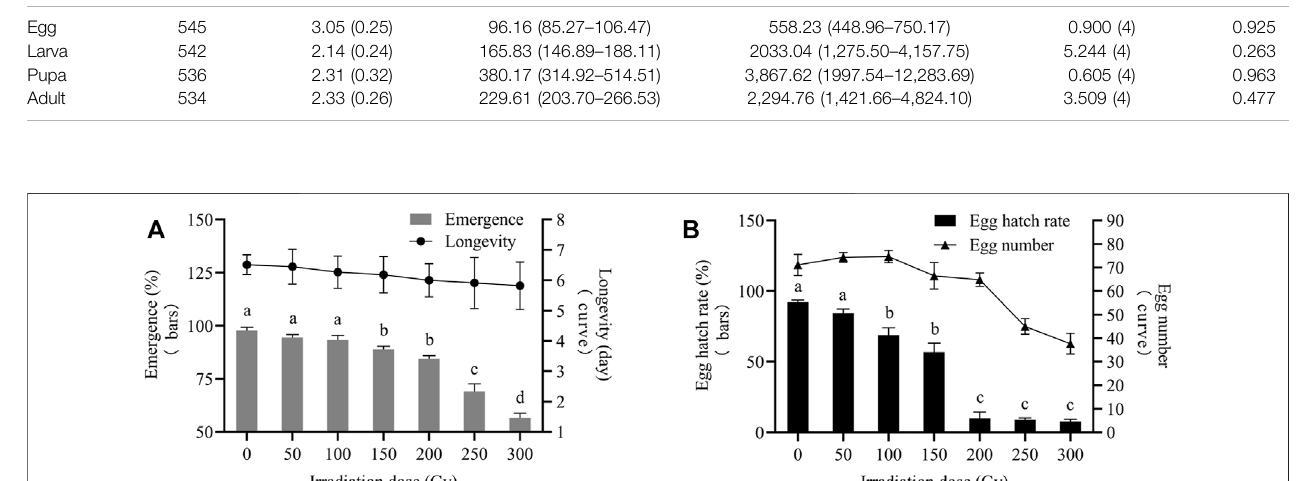
TABLE 1 | Effective dose values of different developmental stages of Ephestia elutella based on mortality. Stage